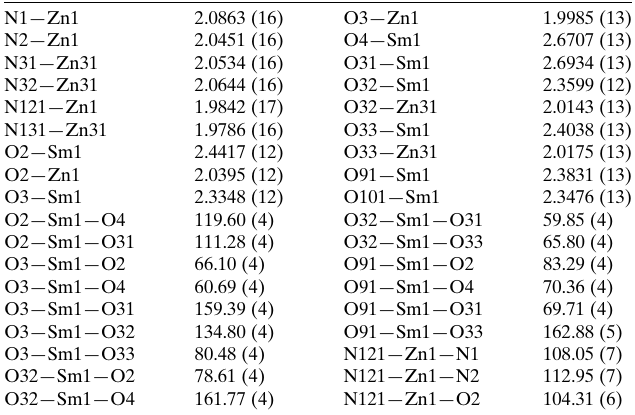
Table 1 Selected geometric parameters (A˚ , (cid:4)